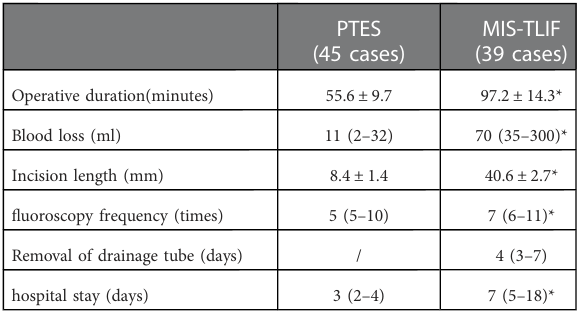
TABLE 2 Operation-related data in PTES and